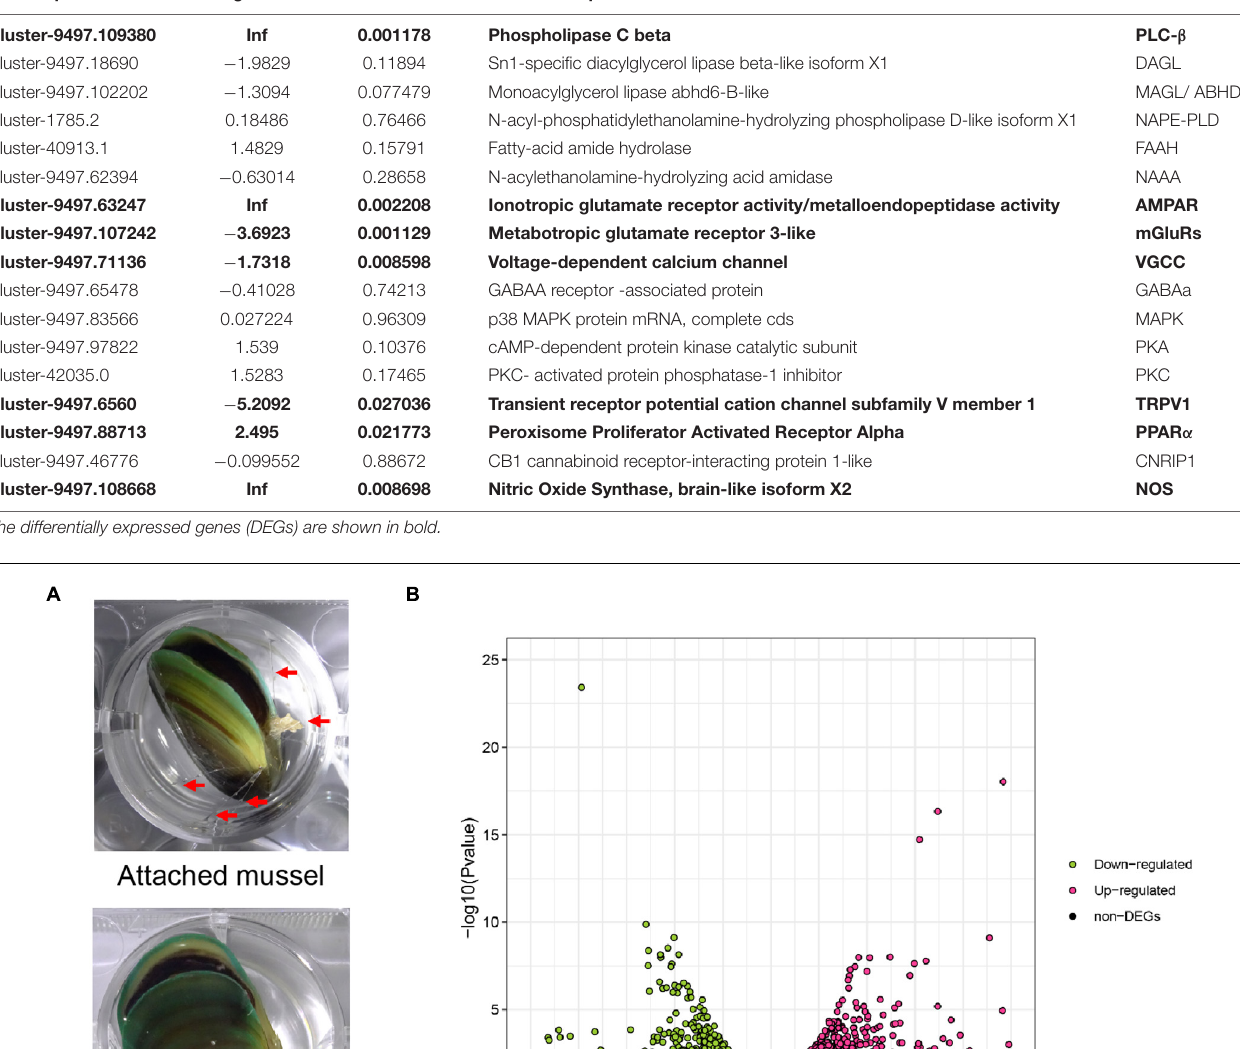
TABLE 1 | List of annotated genes involved in endocannabinoid signaling.